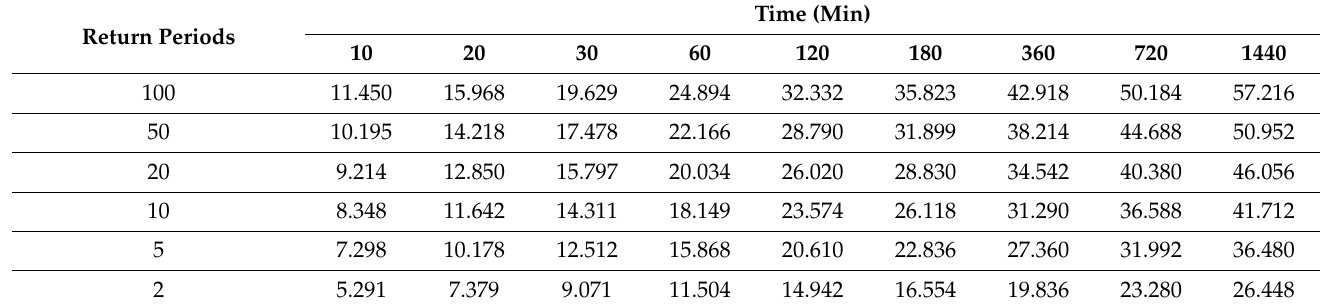
Table 7. Depth of rainfall for different return periods of the study station.